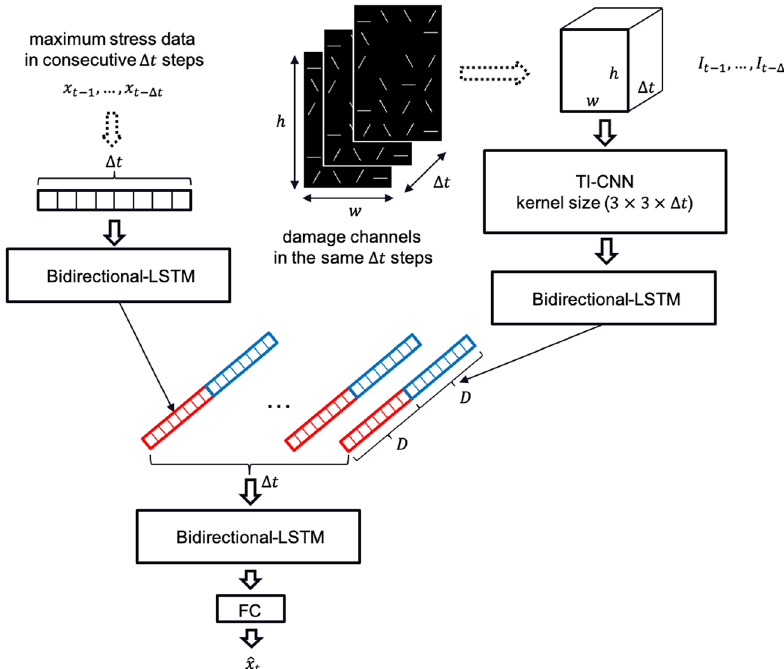
Fig. 7 Architecture of StressNet. The model consists of two branches. In the left branch, the Bi-LSTM encodes the temporal dependency among historical maximum stress data into a series of vectors. In the right branch, TI-CNN followed by Bi-LSTM encodes the spatial and temporal information of the damage channel into another series of vectors. By fusing features from these two branches, StressNet can predict the maximum stress at the next time